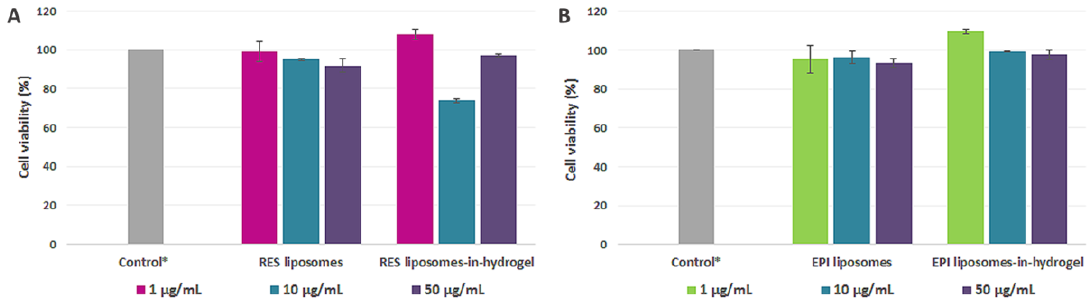
Figure 7. Cytotoxic effects of RES- ( A ) and EPI- ( B ) liposomes or liposomes-in-hydrogel on HaCat cell viability compared to the viability of untreated cells (100%). Results are expressed as percentage mean ± SD ( n = 3).